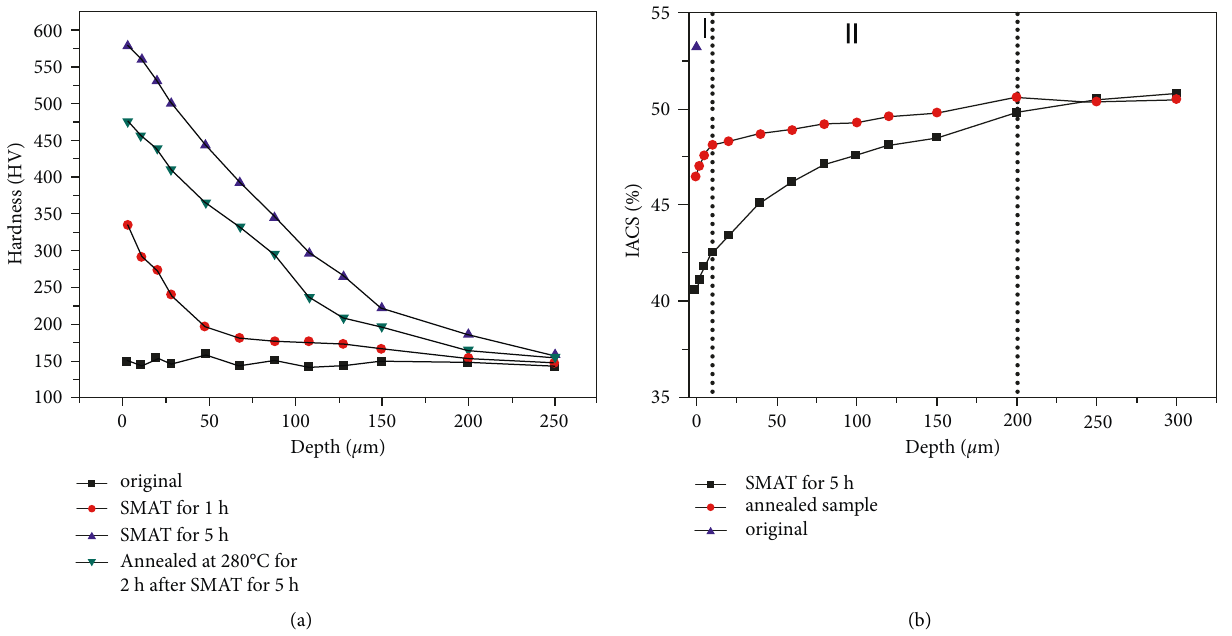
Figure 19: Variations of the microhardness and electrical conductivity with the depth on the cross section of each sample